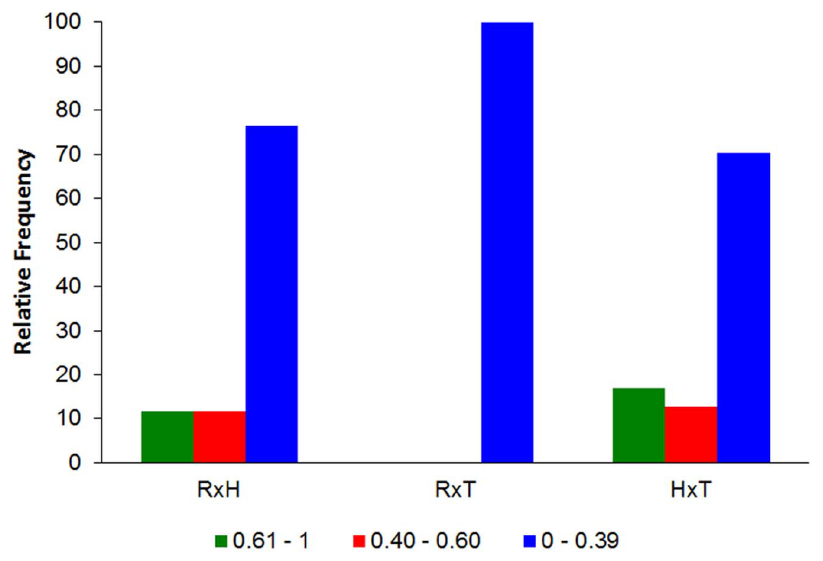
Figure 5. Pianka’s index results. Relative frequency of Pianka’s index of all pairwise interactions between the species analyzed per sampling unit. For specie code see Table